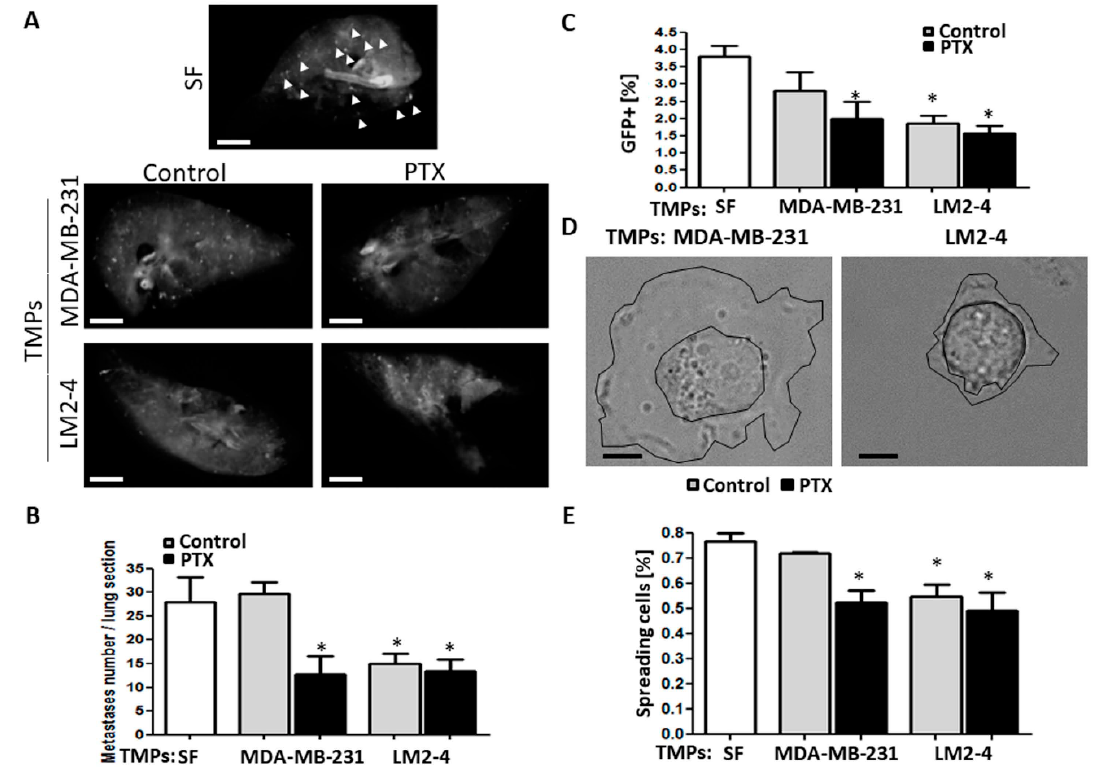
Figure 2. TMPs from highly metastatic cells or cells exposed to chemotherapy decrease tumor cell seeding. ( A – C ) GFP-positive MDA-MB-231 cells cultured with serum-free medium or TMPs from